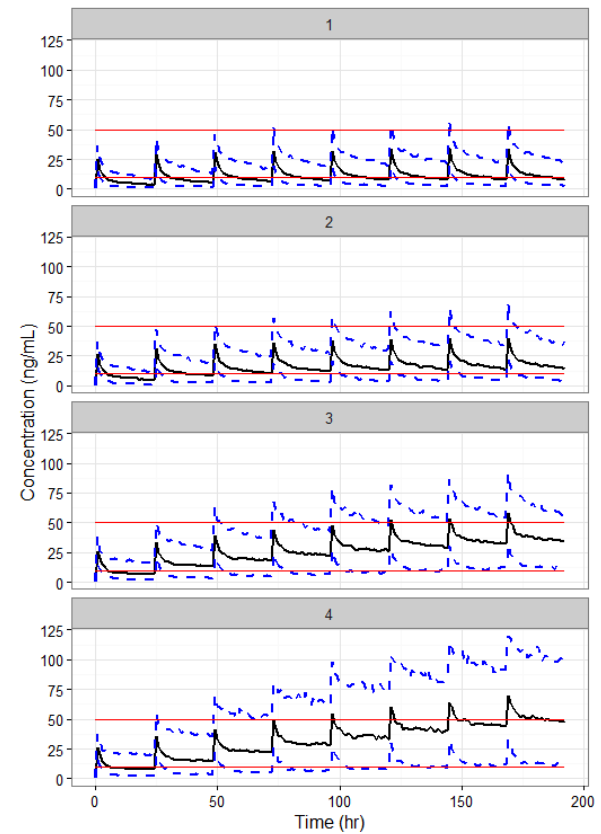
Figure 3. Simulations for plasma vancomycin concentration by virtual patient groups receiving daily 1 g vancomycin (1-h intravenous infusion). Group 1: patients with estimated serum creatinine clearance of 100 mL/min, Group 2: patients with estimated serum creatinine clearance of 40 mL/min CL CR, Group 3: patients receiving continuous renal replacement during vancomycin therapy, Group 4: patients receiving hemodialysis during vancomycin therapy. The black solid line represents the median, the blue lines are 90% prediction intervals, and the red lines are the representative target C peak (50 mg/L) and C trough (10 mg/L) of VCM.